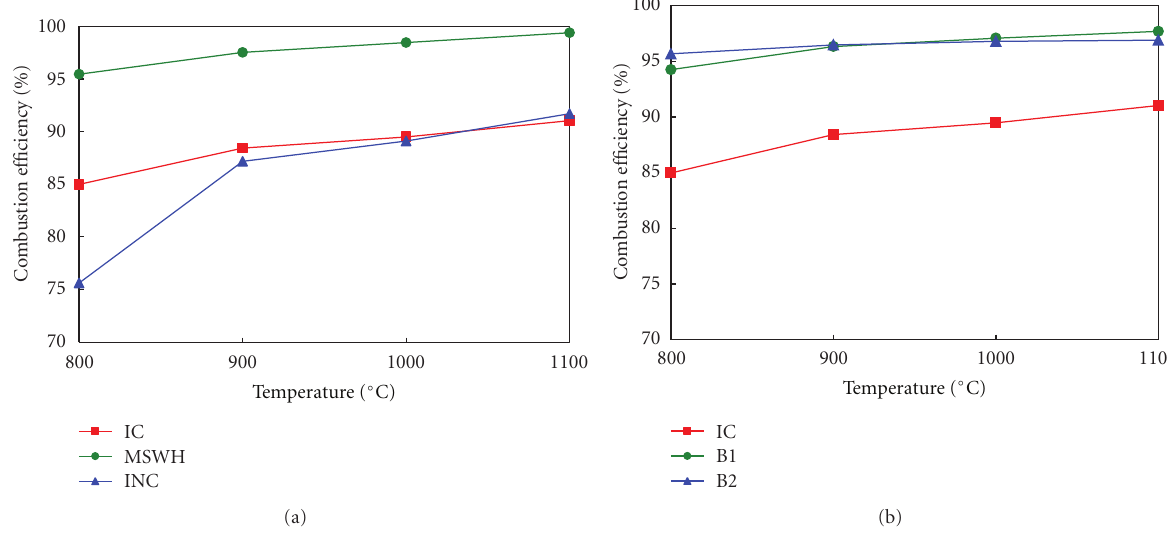
Figure 3: Combustion e ffi ciency as a function of temperature ( ϕ =